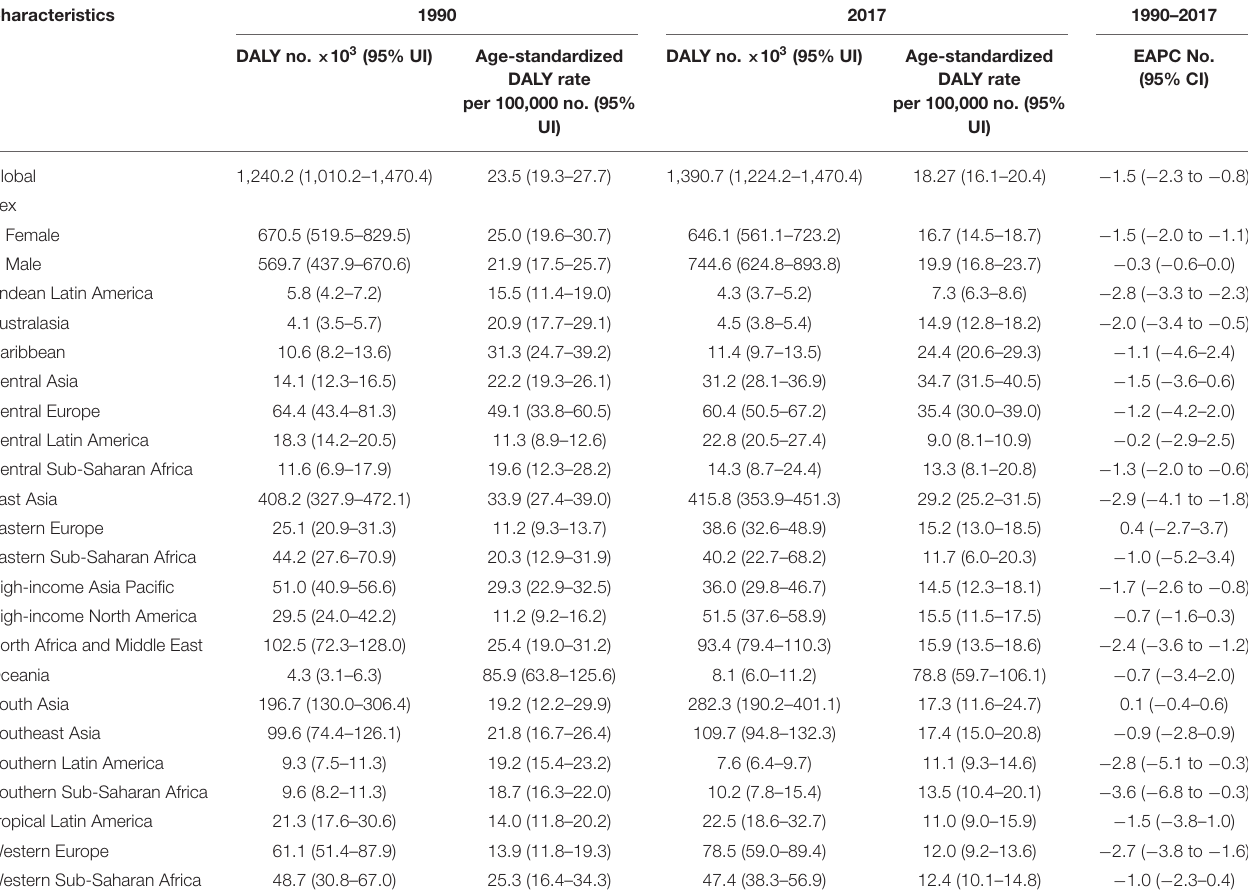
TABLE 3 | The DALY and age-standardized DALY rate of myocarditis between 1990 and 2017 and its temporal trends from 1990 to 2017.